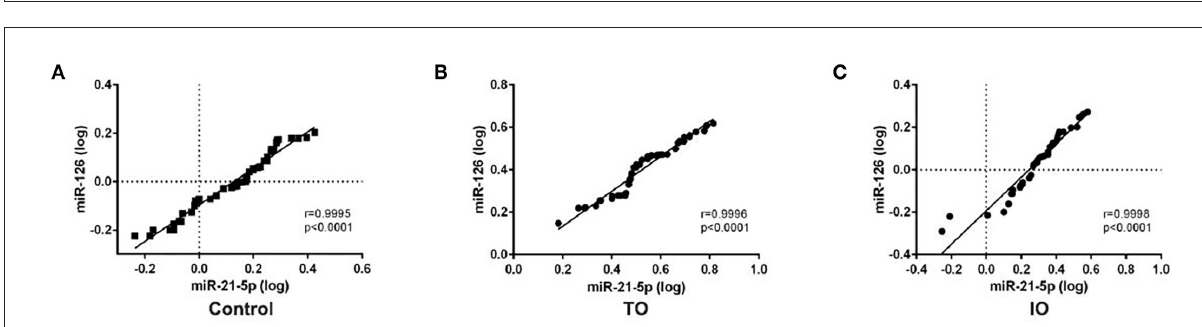
FIGURE2 Spearman’s correlation coefficient between circulating miR-21-5p and miR-126 in all subjects. The scatter plots show the strong correlation between miR-21-5p and miR-126 in the control group ( n = 50), (A) infarct-related artery total occlusion (IR-ATO) acute myocardial infarction